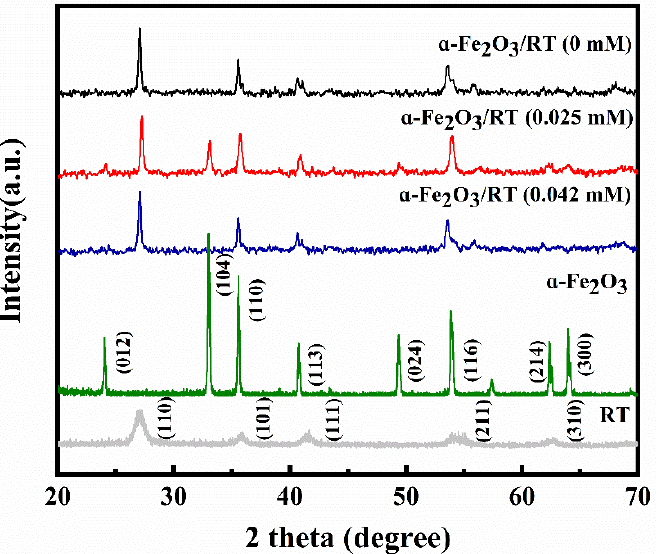
Figure 1. XRD patterns of α -Fe 2 O 3 /RT with phosphate addition of 0 mM, 0.025 mM, and 0.042 mM; α -Fe 2 O 3 and RT.